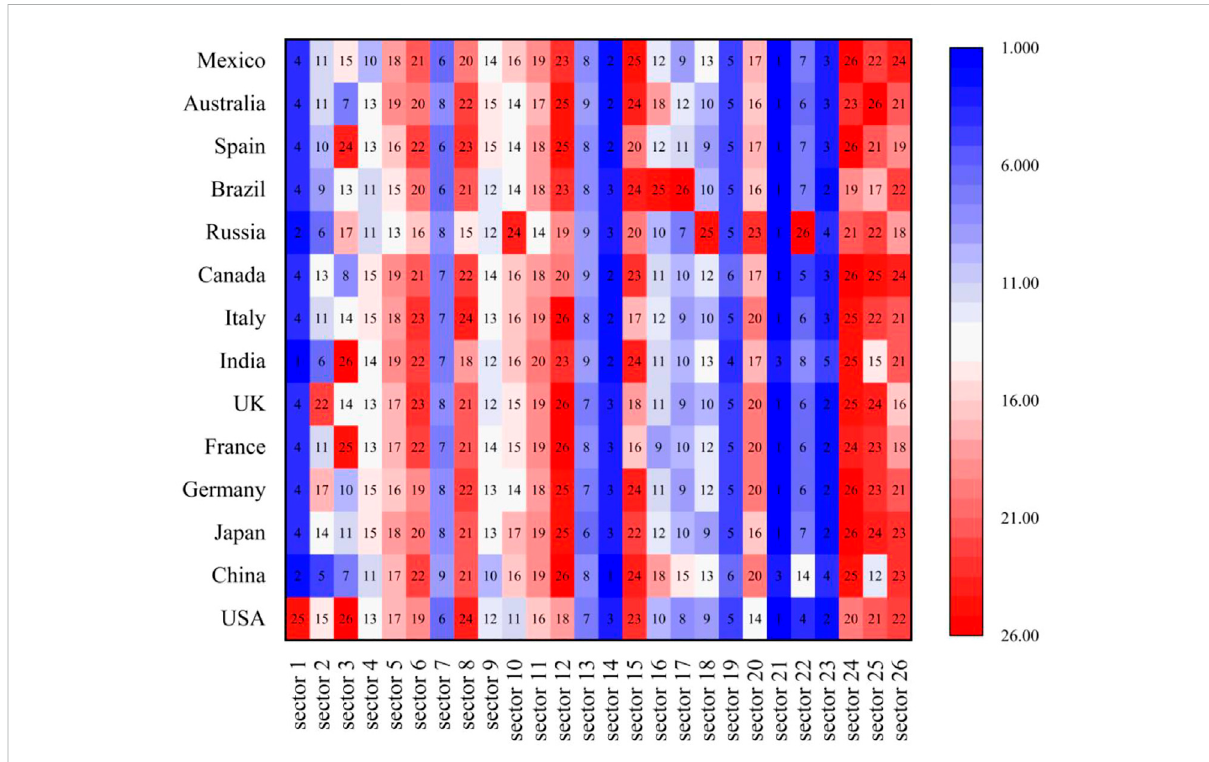
FIGURE 7 Biodiversity net importing countries sectoral threat ranking. Note: See Supplementary Appendix Table S2 for the speci fi c corresponding departmentnames;therankingofchromaticity bandsrepresentstheseverityofthreatsfromdepartments;thenumbersinthesquaresrepresentthe ranking of threats to biodiversity from 26 departments in this